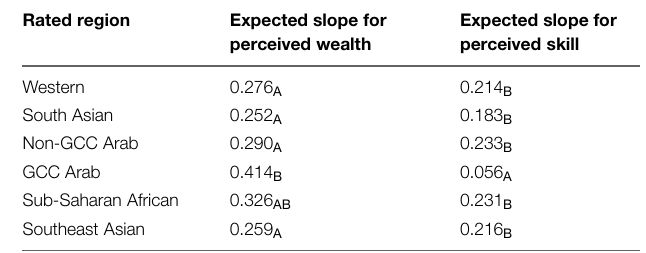
TABLE 9 | Slopes and homogenous subsets for perceived wealth and perceived skill by rated